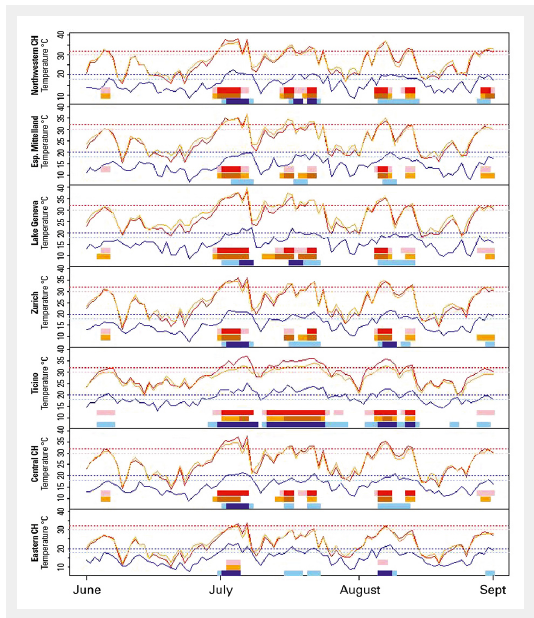
Daily maximum apparent (red line), daytime maximum (orange line) and night-time minimum (blue line) temperatures in each Swiss region in summer 2015. Horizontal bars indicating the heatwave days of at least 2 days’ length identified according to the three temperature indicators and two different thresholds. Horizontal dashed lines correspond to the temperature thresholds used for the heatwave (at least 2 consecutive days) identification (dark red/ orange, 32 °C; light red/orange, 30 °C; dark blue, 20 °C; light blue, 18 °C).